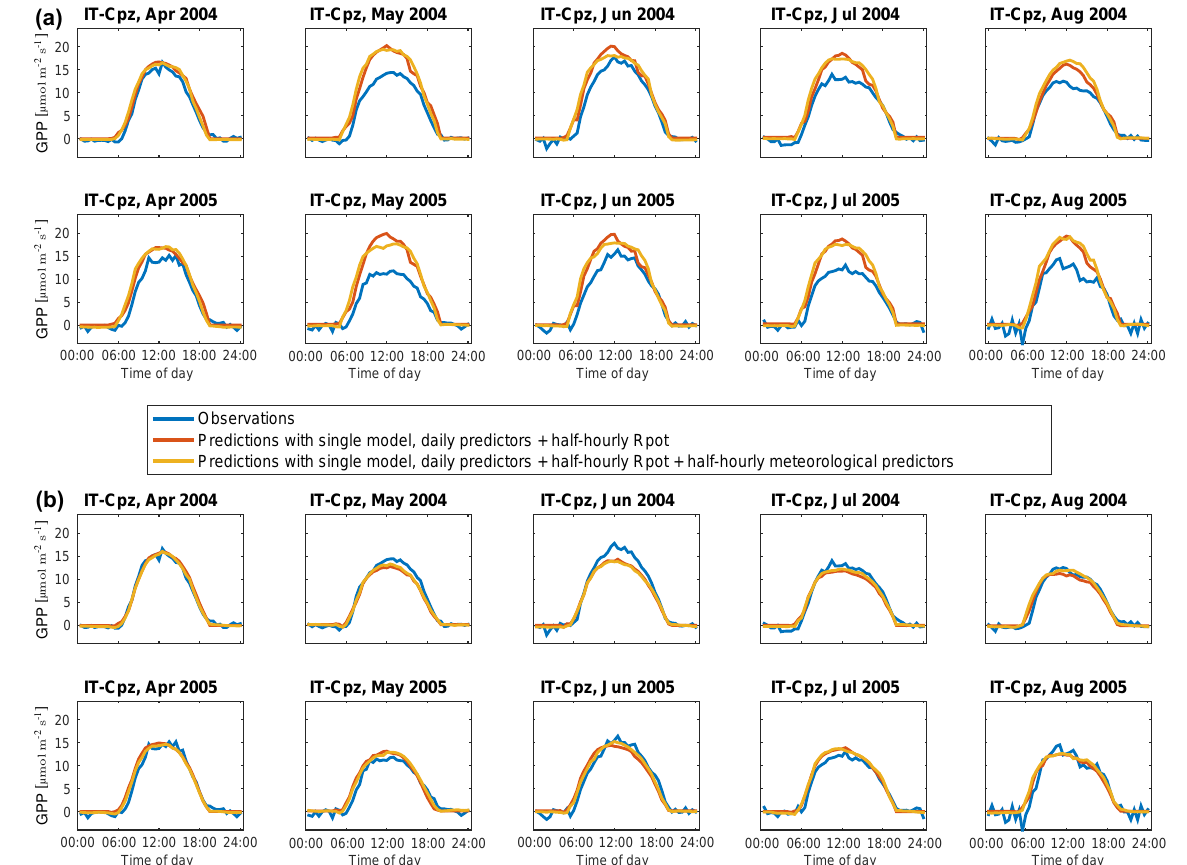
Figure 10. Comparison between leave-one-site-out (a) and leave-one-month-out (b) at IT-Cpz. It can be observed that site-specific training in the leave-one-month-out setup reduces the prediction errors during seasonal droughts. Thus, the drought effects only lead to problems when training across sites and predicting fluxes in the leave-one-site-out setup or for the upscaling when fluxes are estimated at locations where no towers